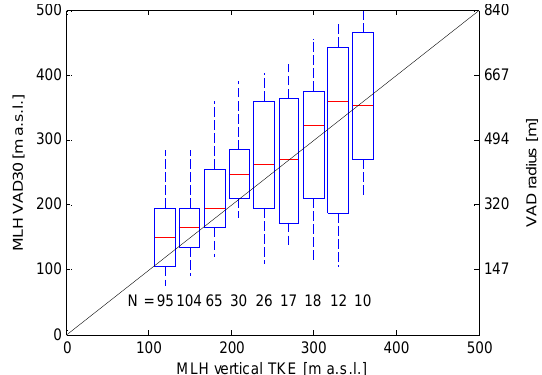
Figure 8. Comparison of vertical TKE dissipation-rate-based MLH estimate and σ 2 -based MLH for 30 ◦ elevation angle VAD at Li- VAD massol. Red line indicates median, blue rectangle indicates upper and lower quartiles and whiskers indicate the 10th and 90th per- centile. Black line indicates 1 : 1 line. The right-hand side axis indi- cates the radius of the VAD corresponding to the elevation on left- hand side